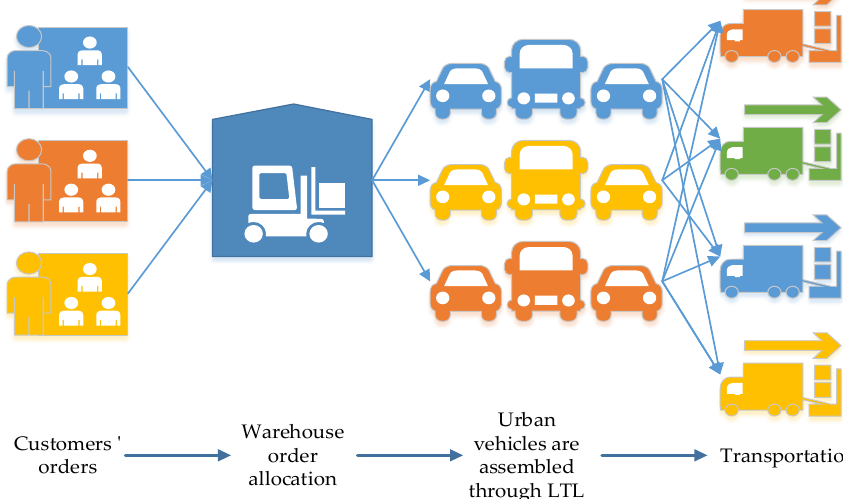
Figure 1. Description of urban network location problem.